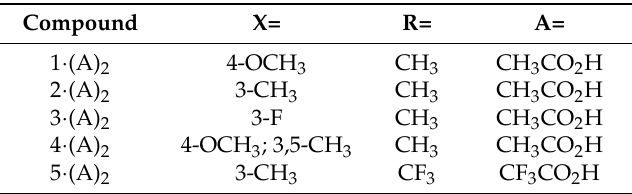
Figure 3. General two-step reaction scheme of the binuclear rhodium complex with the formula [Rh 2 {(XC 6 H 3 )P(XC 6 H 4 )} n (OCR) 2 ] · A 2 . The color of the complex turns from violet to orange-yellow. Cf. Table 2 for the definition of the ligands. Table 2. Ligands of the rhodium compounds 1 · (A) 2 –5 · (A) 2